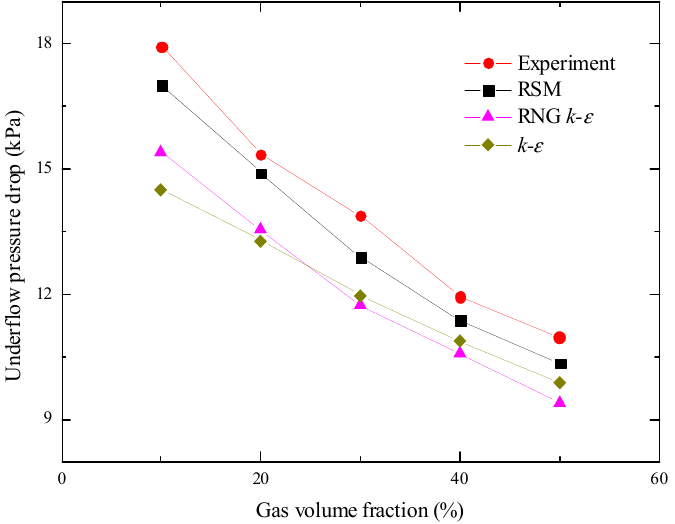
Figure 7. Comparison of experimental and simulated values.